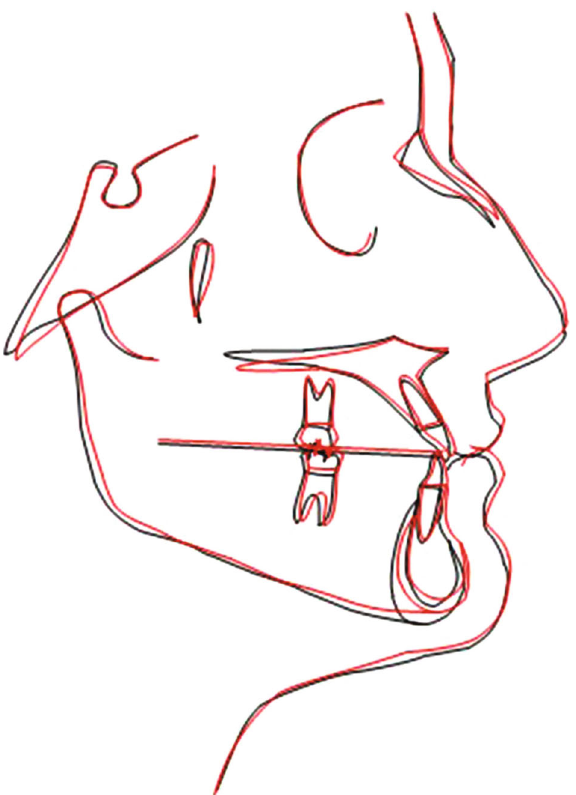
Figure 18: Cephalometric